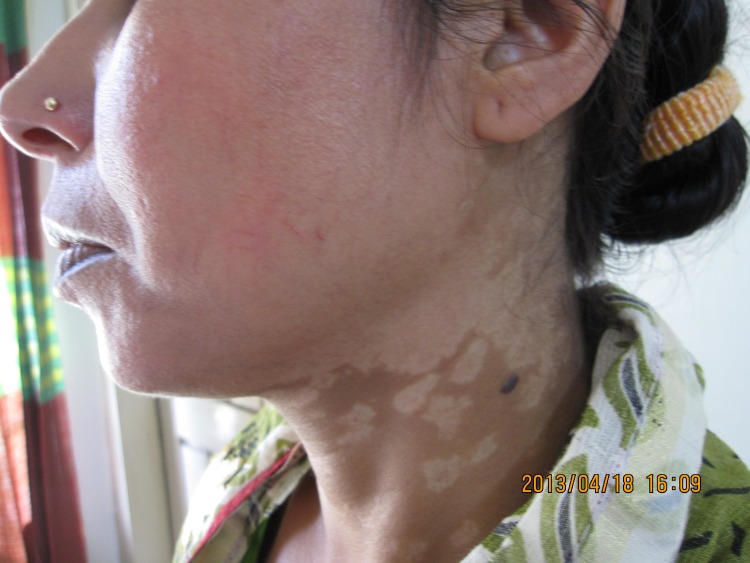
PKDL from Bangladesh: confluent macular rash involving most of the face (courtesy of Dr. Dinesh Mondal).PKDL; post-kala-azar dermal leishmaniasis.